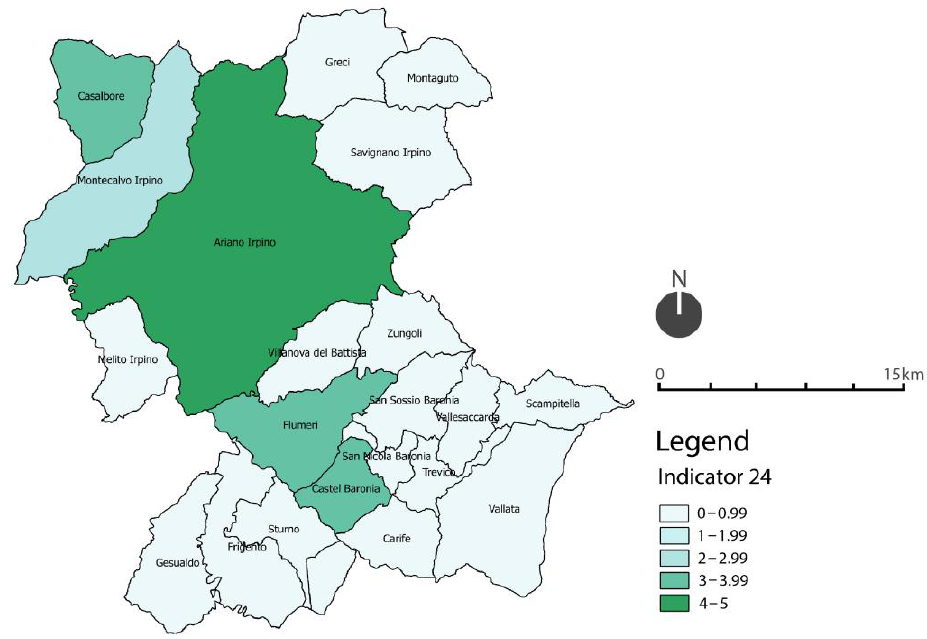
Figure 4. Map of indicator 24 “Investment in the green economy” © RI.P.R.O.VA.RE Project.